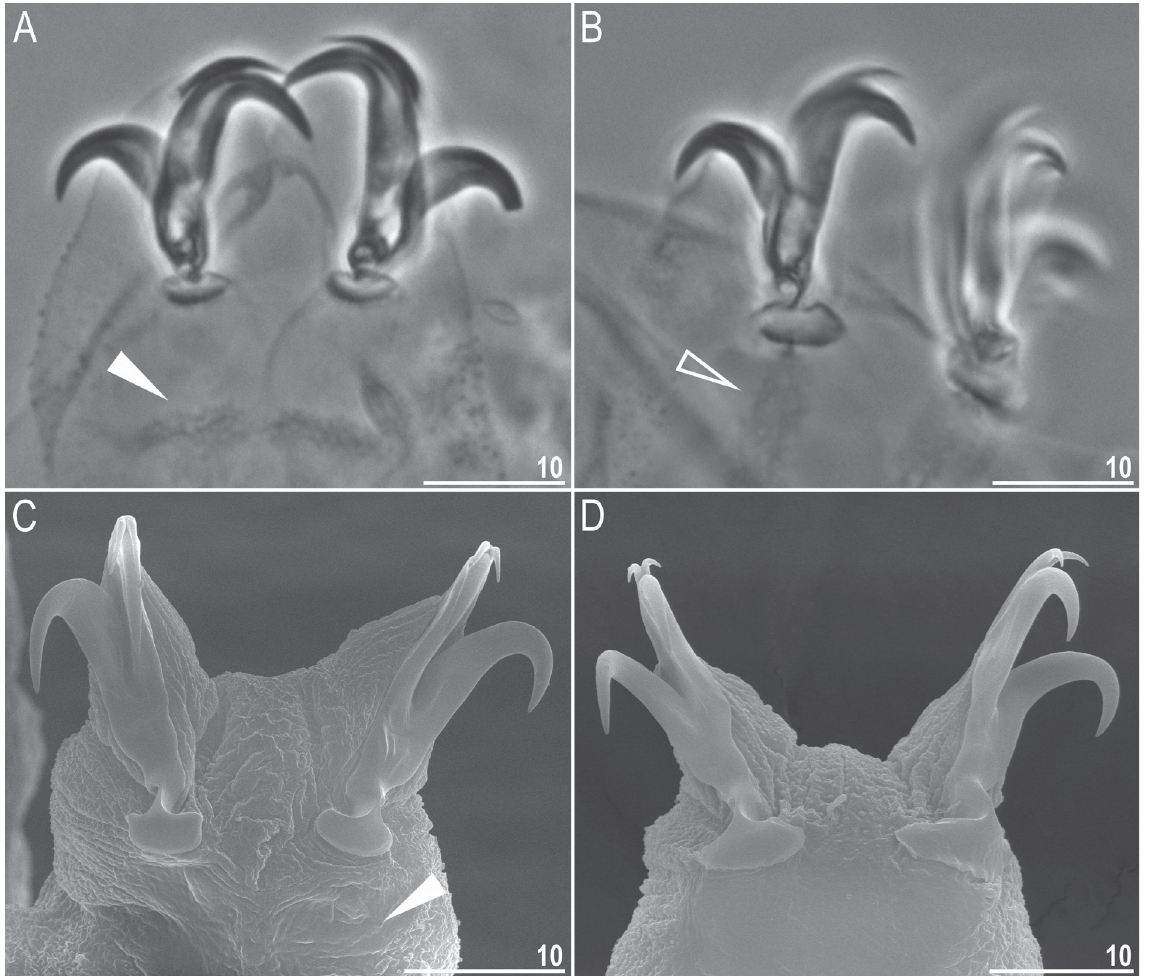
Fig. 12. Macrobiotus cf. recens Cuénot, 1932 , Gran Canaria, claws. A–B . Claws III and IV seen under PCM, with smooth and weakly crenulated lunules, respectively. C–D . Claws II and IV seen under SEM, with smooth and weakly crenulated lunules, respectively. A and B assembled from several photos. Filled arrowheads indicate faint cuticular bars under claws whereas empty arrowhead indicates a horseshoe- shaped structure. Scale bars in